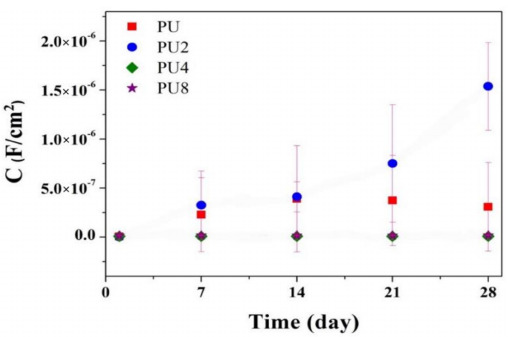
Figure 6. Evolution of coating capacitance of various coating samples during 28 days of immersion in 3.5 wt.% NaCl